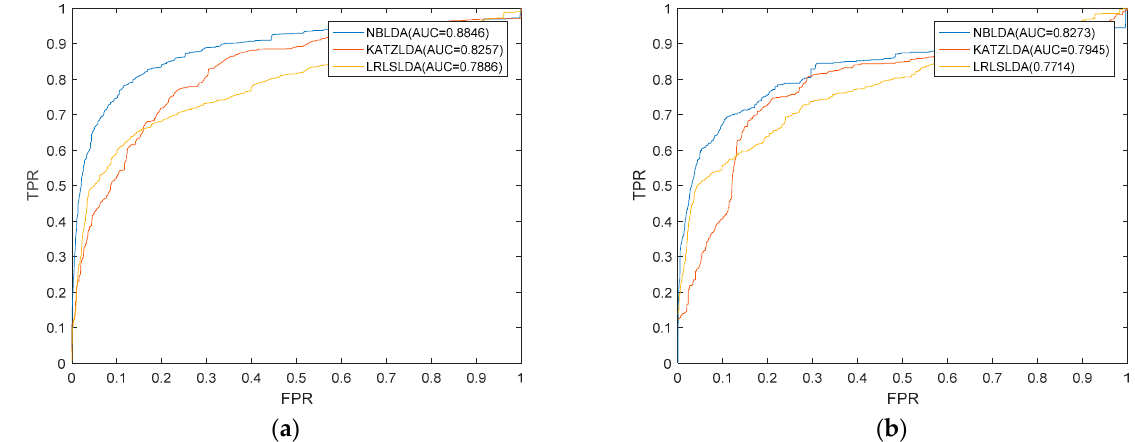
Figure 1. We compared the prediction performance of NBLDA with two classical methods for lncRNA-disease association prediction (KATZLDA and LRLSLDA). ( a ) Areas under the ROC curve (AUCs) achieved by NBLDA, KATZLDA, and LRLSLDA based on the dataset of DS 1 ; ( b ) AUCs achieved by NBLDA, KATZLDA, and LRLSLDA based on the dataset of DS 2 .